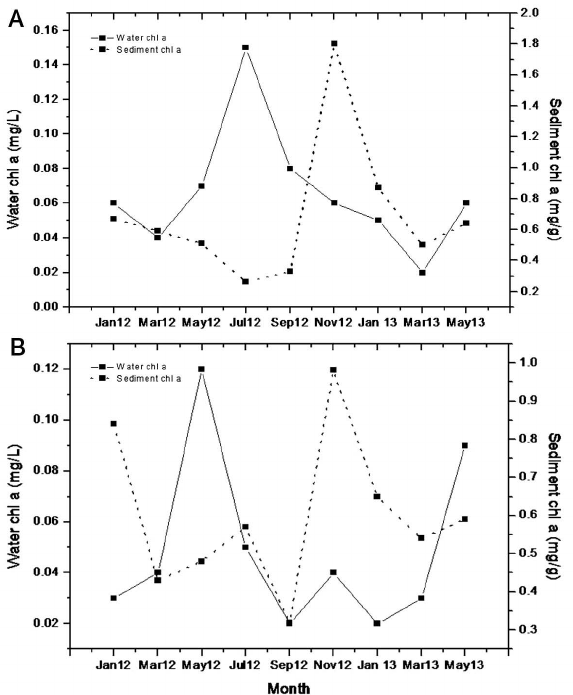
Fig. 5. – Seasonal variations in sediment chlorophyll a and water chlorophyll a at Site 1 (A), Payyannur (PNR) and Site 2 (B), Pan- ambur (PNBR).